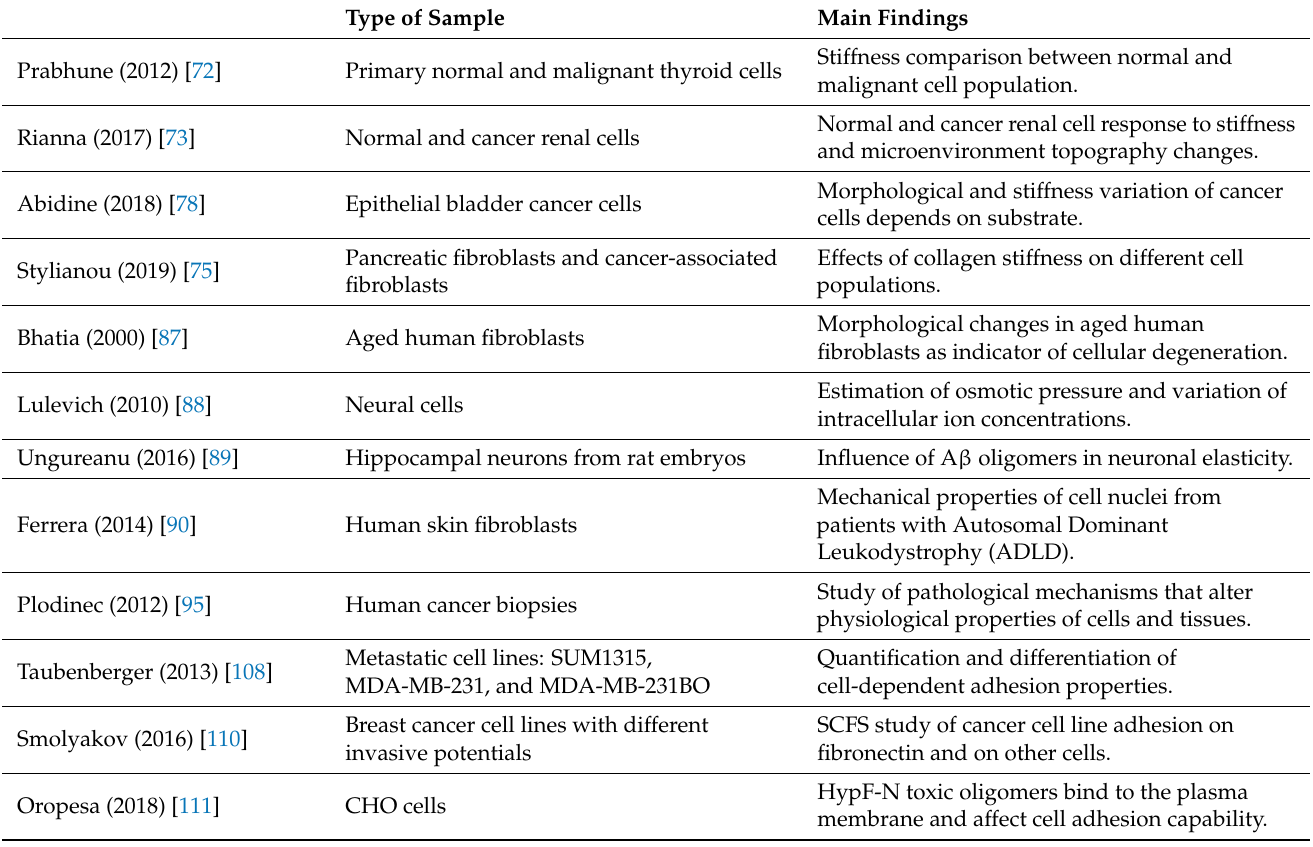
Table 1. Cont. Type of Sample Main Findings Primary normal and malignant thyroid cells Normal and cancer renal cells